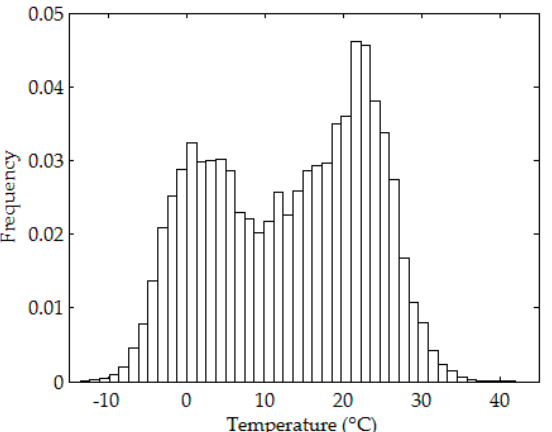
Figure 2. Ambient temperature frequency distribution histogram (Jun. 2009 to Jun. 2017).